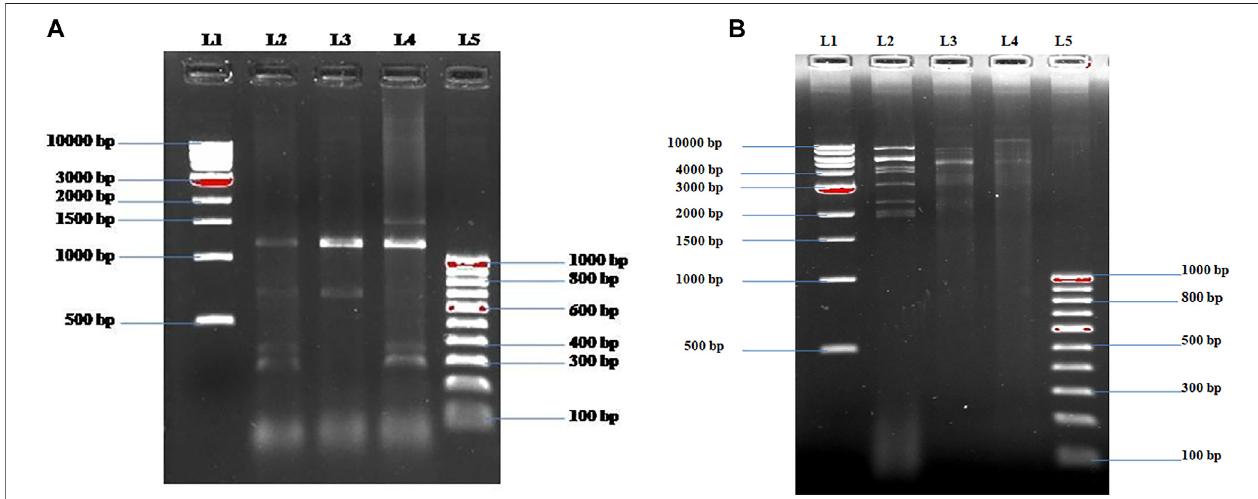
bacteriophages genomic DNA. The phage DNA was digested with restriction enzyme EcoRI and run on 1% agarose gel. Lane-1: molecular marker (1 kb) (L1); lane-2 ɸ KpBHU4 (L2): lane-3 ɸ KpBHU7 (L3): lane-4: ɸ KpBHU14 (L4); and lane-5: molecular marker (100 bp) (L5).